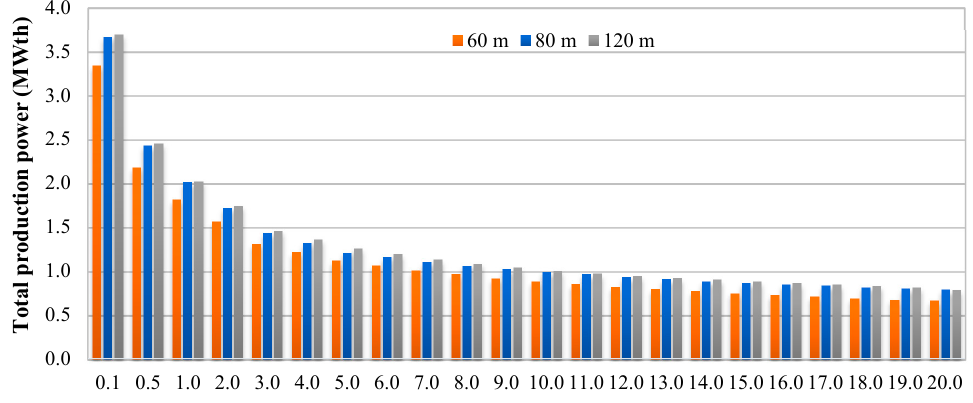
Figure 11. Schematic of cumulative energy produced during 20 years through combined four half fracture model with 60, 80, and 120 m fracture spacing. Energies 2020 , 13 , x FOR PEER REVIEW